Question: What visual encoding does this figure use to show its data?
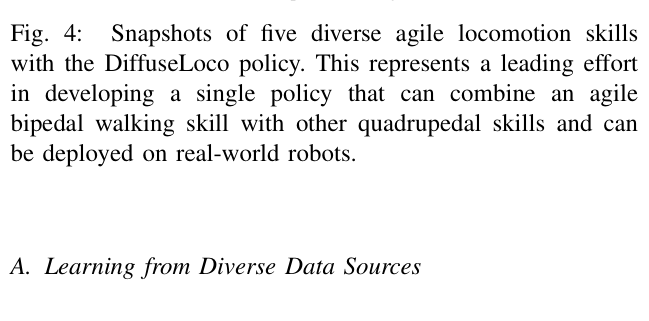
Answer: line